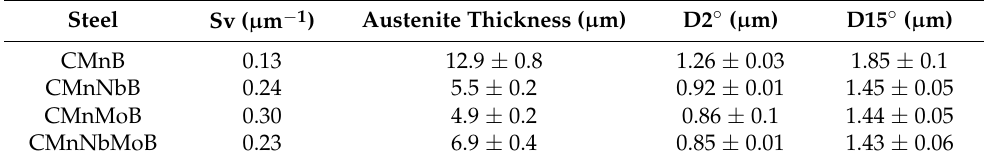
Table 3. Measured Sv parameter (grain boundary area per unit volume) and average austenite thickness for the different alloys: mean unit sizes were quantified by EBSD considering low- and high-angle misorientation